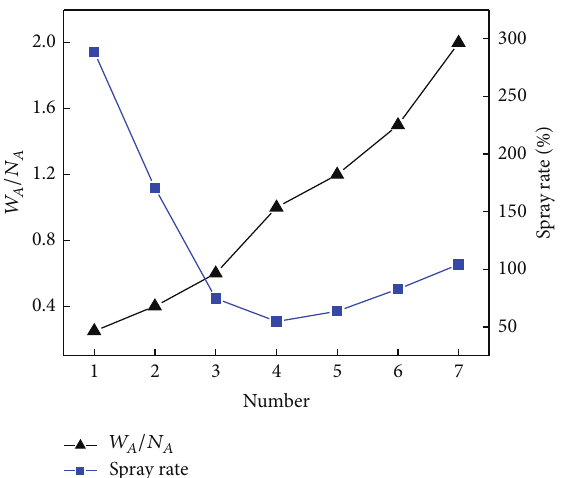
Figure 11: Over spray rate under different network